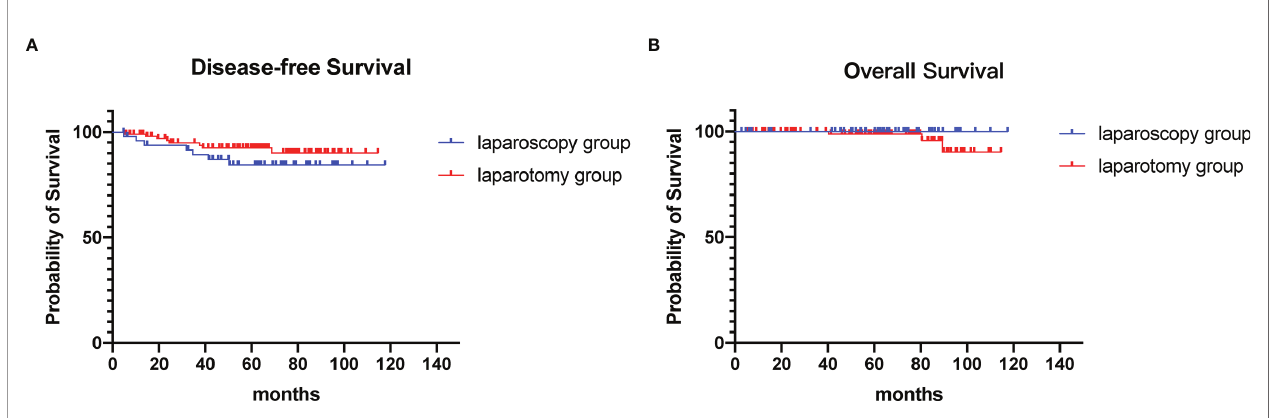
FIGURE 1 | Survival outcomes of patients. (A) Disease-free survival (B)